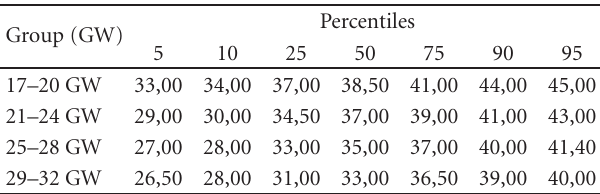
Figure 2: Transvaginal ultrasound image of the cervical funneling. Table 1: Percentile values for CL between 17 and 32 weeks of